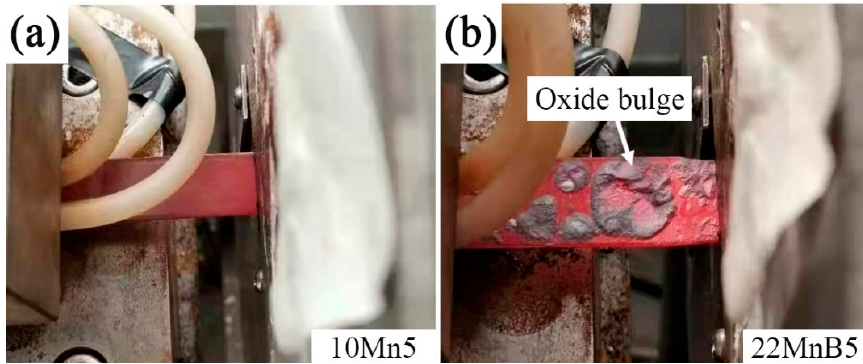
Figure 4. Photos of the sheet after austenitizing (before the wear test), ( a ) 10Mn5; ( b )